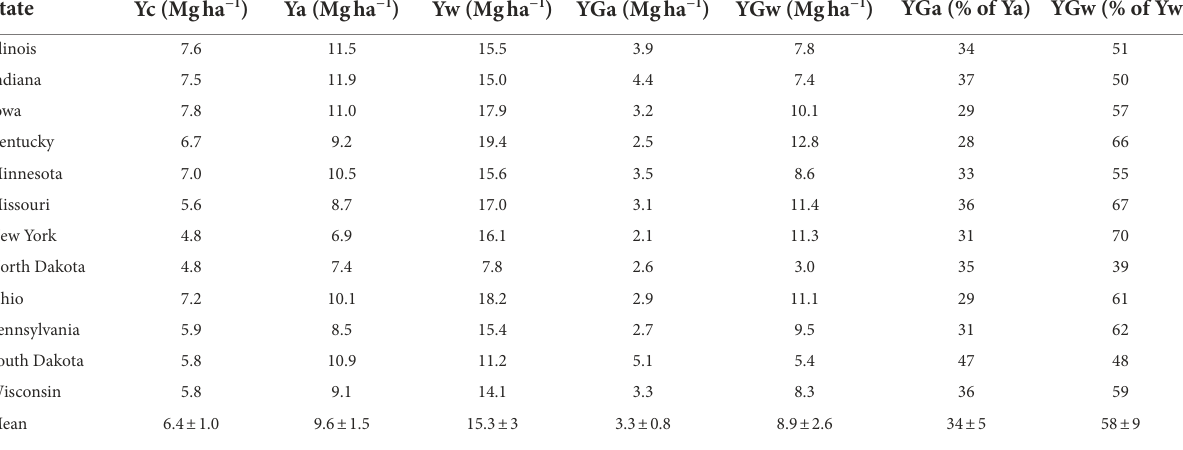
TABLE 4 State-level current yield (Yc), attainable yield (Ya), water-limited potential yield (Yw) and yield gap in comparison to attainable (YGa) and water-limited yield (YGw).